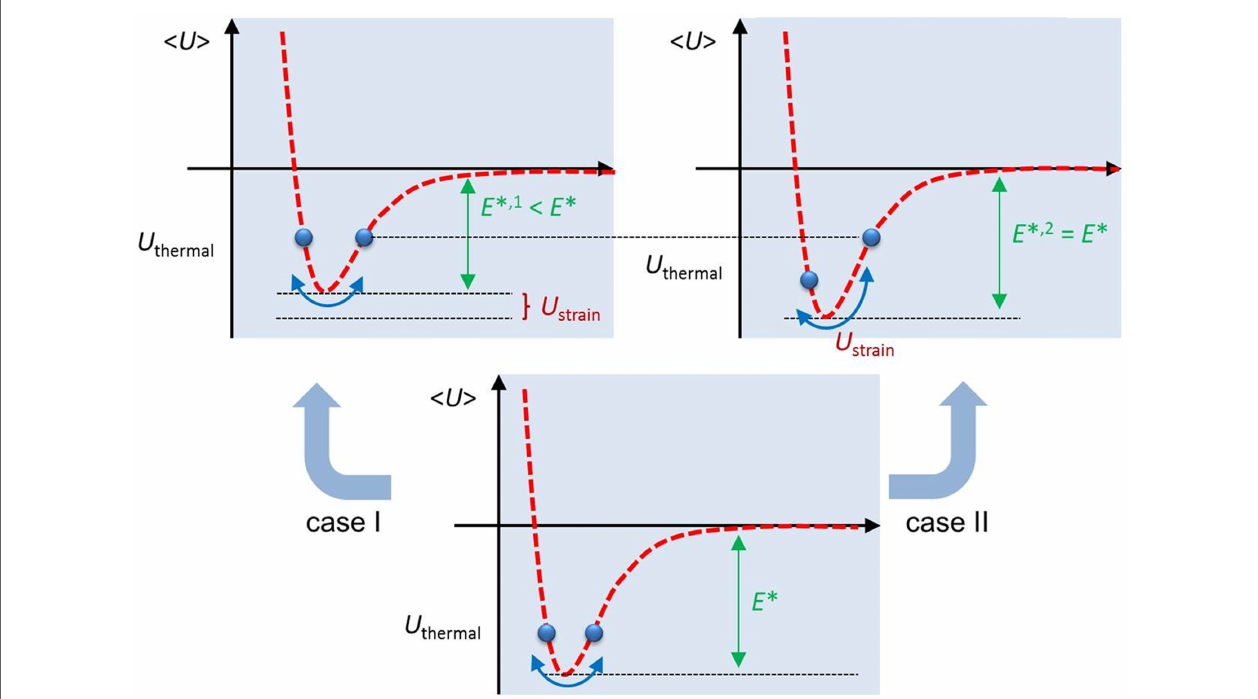
FIGURE 2 | Schematic representation of how temperature and applied stresses interact with the potential energy well of the chemical bond at the crack tip. < U > is the average potential energy of the bond as a function of distance, U thermal is the thermal energy, U strain is the strain energy, and E *, E * ,1 , and E * ,2 are the activation energies for bond cleavage for non-strained bonds and strained bonds, case I and II,